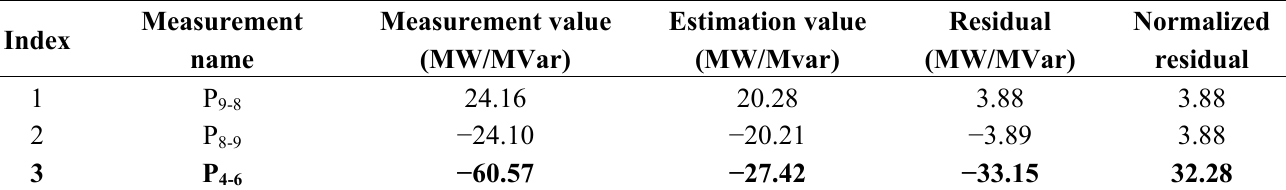
Table 1. Suspicious measurements in a 9-node